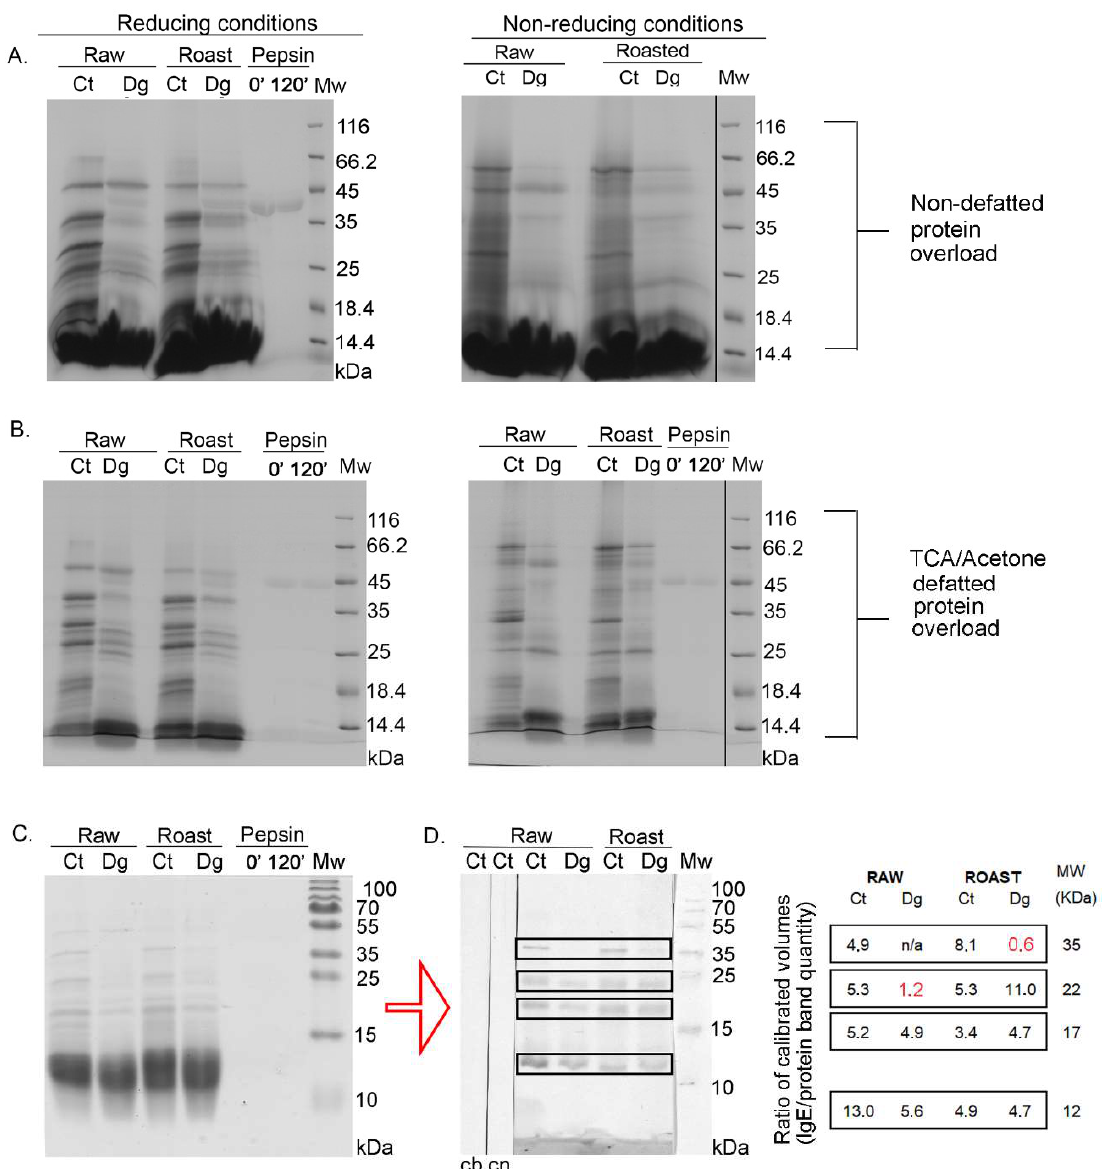
Figure 1. 1D SDS-PAGE and 1D immunoblot of raw and roasted hazelnut digesta and their controls. ( A ) 1D SDS-PAGE, reducing condition of overloaded protein profiles from non-defatted raw and roasted gastric hazelnut digesta and their respective controls. ( B ) 1D SDS-PAGE, reducing (left) and non-reducing conditions (right), for overloaded protein profiles of raw and roasted gastric hazelnut digesta and their controls, which were defatted with TCA–acetone treatment. ( C ) 1D SDS-PAGE, reducing condition of normal load range of raw and roasted gastric hazelnut digesta and their controls, also used for 1D Western blots. ( D ) 1D Western blot of non-defatted raw and roasted gastric hazelnut digesta and their controls, probed with the pool of patients’ sera (left panel). Bound IgE was detected by rabbit anti-IgE antibody. SDS-PAGE was performed under reducing conditions. Right panel: Densitometry-quantified IgE-reactive binding, normalized with the quantity of proteins in respective gel bands (red text denotes values that have not been normalized due to absent gel band after densitometric detection). Ct, control sample (non-digested, e.g., without pepsin) after 120 min; Dg, gastric phase at 120 min; 0 (cid:48) —pepsin control at the start of the digestion; 120 (cid:48) —pepsin control at the end of digestion (120 min); cb, control of secondary antibody; cn, control with non-allergic patient serum; Mw, molecular weight markers; kDa, Kilo